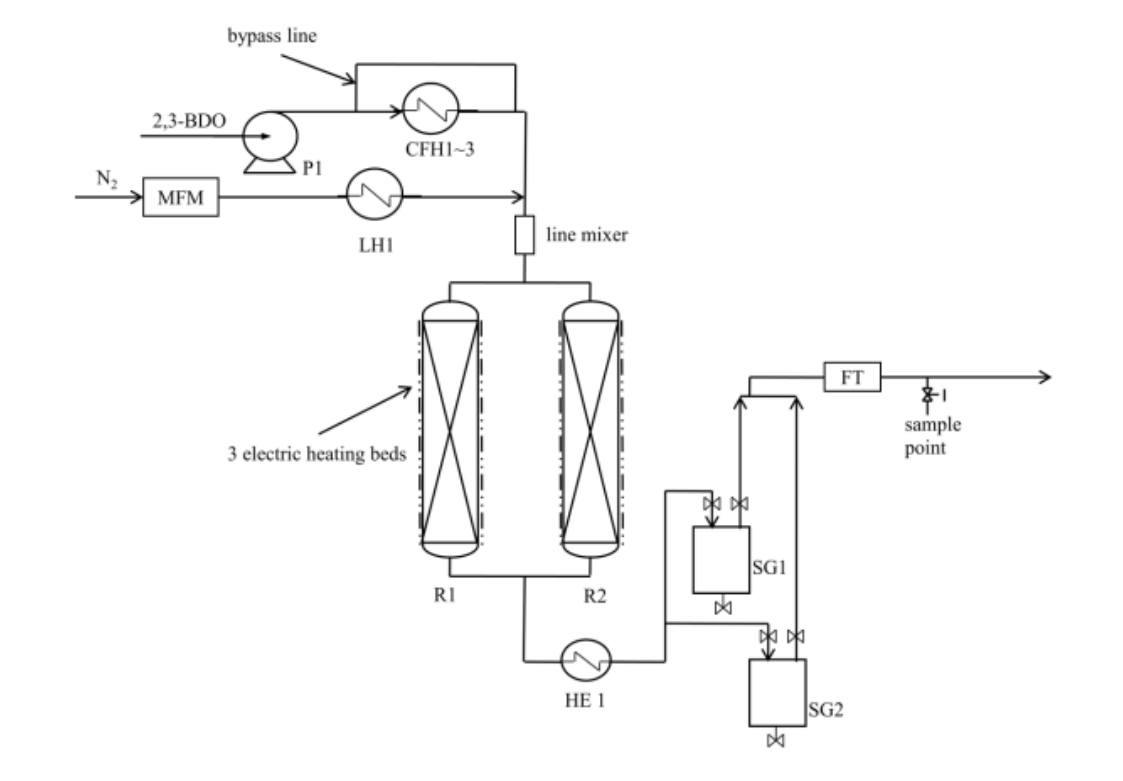
Figure 1. The dehydration of the 2,3-BDO pilot system [20].